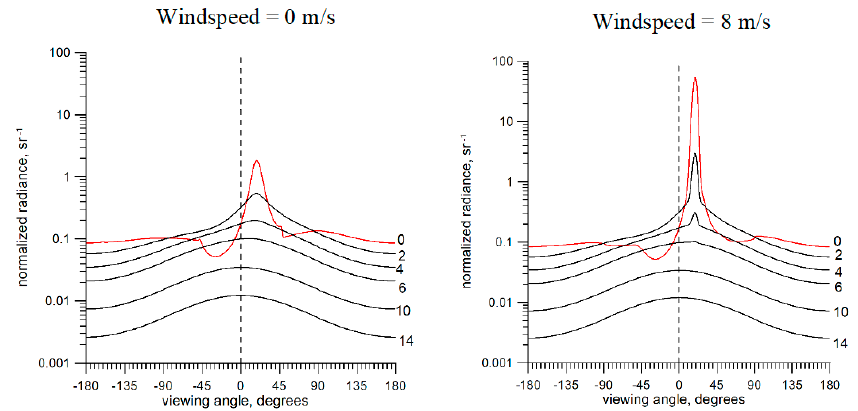
Figure 7. Black Sea. Comparison of the radiance distributions for cases of smooth and rough surfaces; a (440 ) = 0.09 m − 1 , θ 0 = 25 ◦ , λ = 530 HM, N coc = 5 10 6 cell / L. All others are the same as in Figure